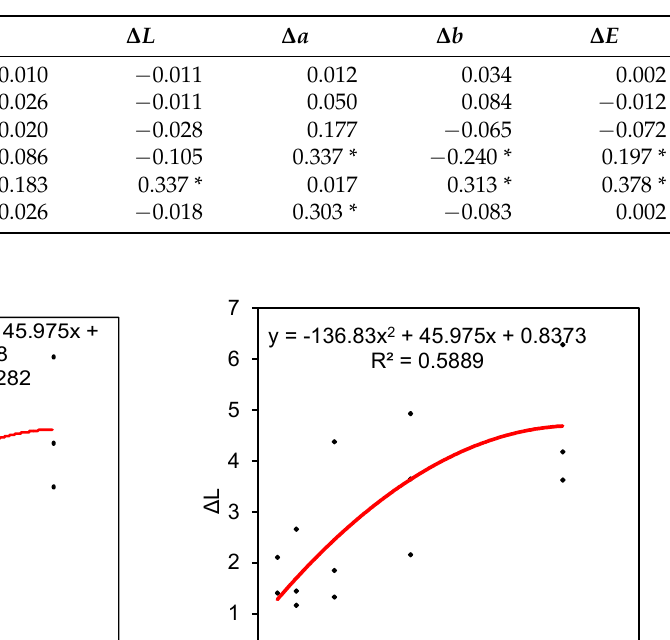
Table 4. Correlations matrix for relationships of PGR rates vs. turfgrass color parameters.